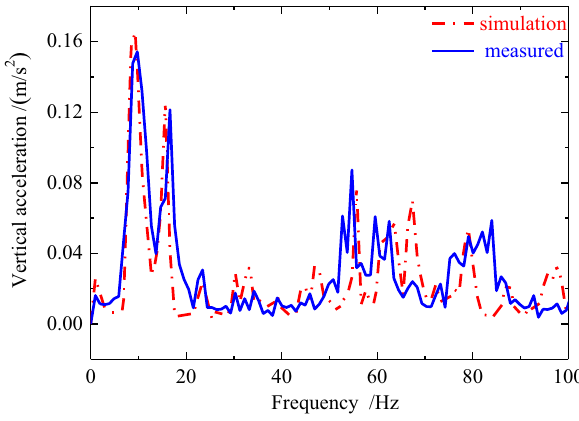
Fig. 6 Comparison of the simulation and measurement frequency– history curves